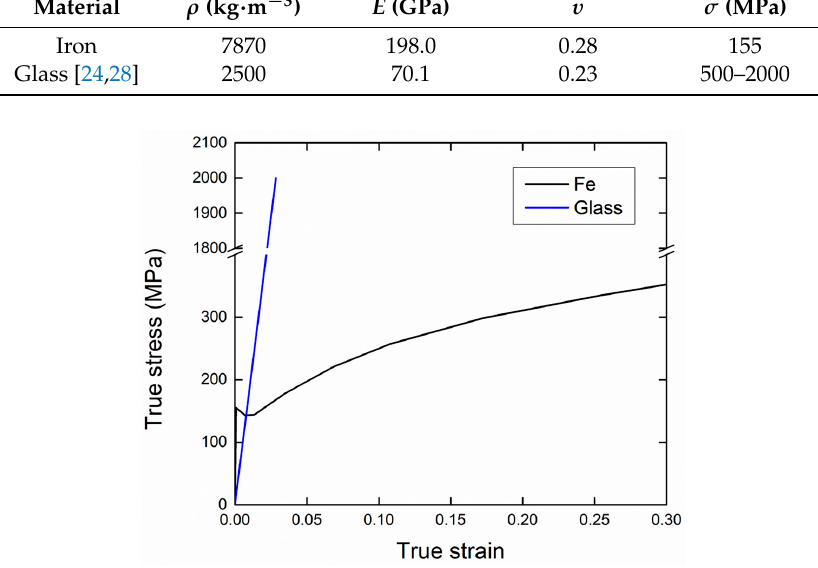
Figure 4. True stress–strain curves of the iron and glass [24,28] used for input data. Table 1. Material properties used for numerical analysis.